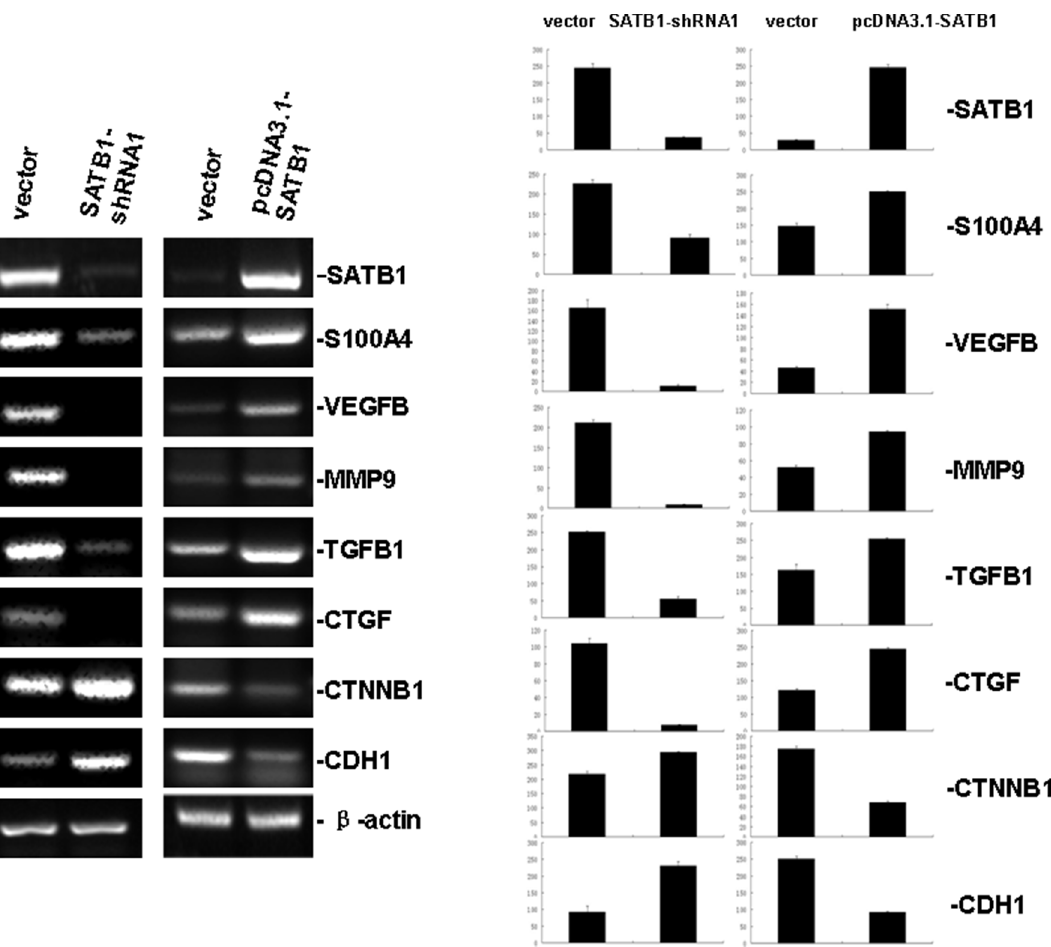
Figure 6. SATB1 regulates gene expression in CRC cells. The expression level of genes associated with CRC carcinogenesis and metastasis were determined in empty vector, SATB1-shRNA1, and pcDNA3.1-SATB1 cell lines by RT-PCR. Knockdown of SATB1 expression downregulated S100A4, VEGF-B, MMP-9, TGF b 1, and CTGF expression and upregulated CTNNB1 and CDH1 expression. SATB1 overexpression resulted in the opposite effect.